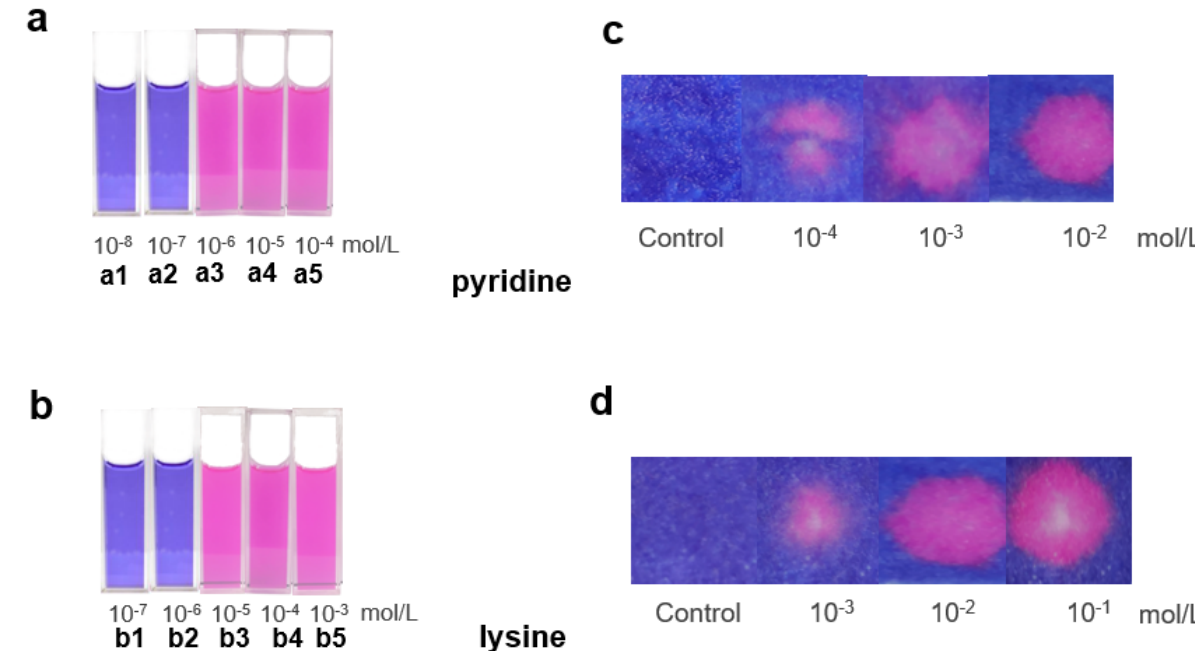
Figure 5. Figures showing the color alternations of C-dots solutions in presence of ( a ) pyridine and ( b ) lysine of different concentrations. Figures showing the color alternations of test papers when dropped with ( c ) pyridine and ( d ) lysine of different concentrations. Table 1. Sensitivities of solution and test paper assays developed from C-dots for the detection of various NCOBs. NCOBs Assays